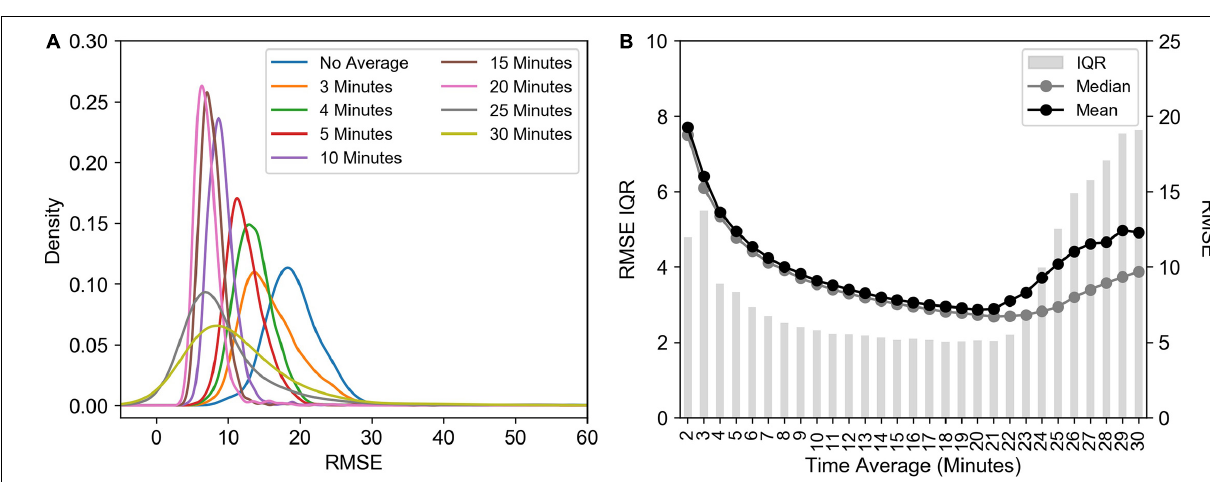
FIGURE 10 | (A) Kernel Density Estimation of RMSE values calculated using different time window averaging using the calculate ρ saturation model. (B) The interquartile range (IQR), median and mean RMSE from the different time windows. All data presented here has been corrected for the FIRe instrument saturation bias, i.e., skipping the first flashlet. Data is from the Southern Ocean (FIRe,